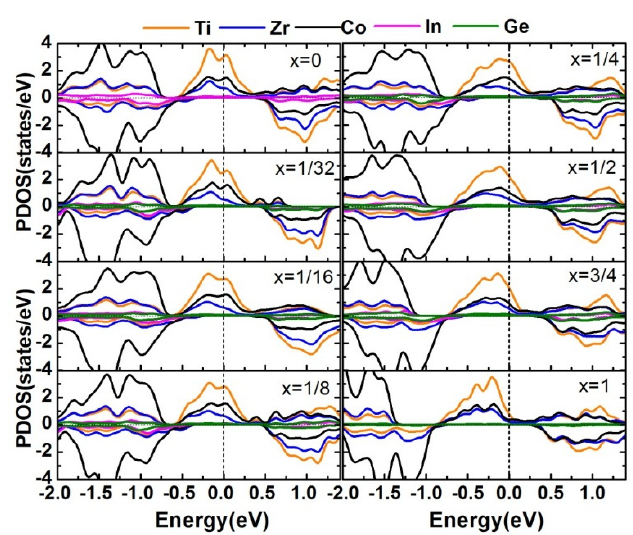
Figure 2. Partial density of states (PDOS) for the ordered TiZrCoIn quaternary Heusler alloy and the doped systems. The orange line is the atomic PDOS for Ti atom, the blue line is for the Zr atom, the black line is for the Co atom, the magenta line is for the In atom, and the olive line is for the Ge atom. Notice that x in the figure is the doping concentration.